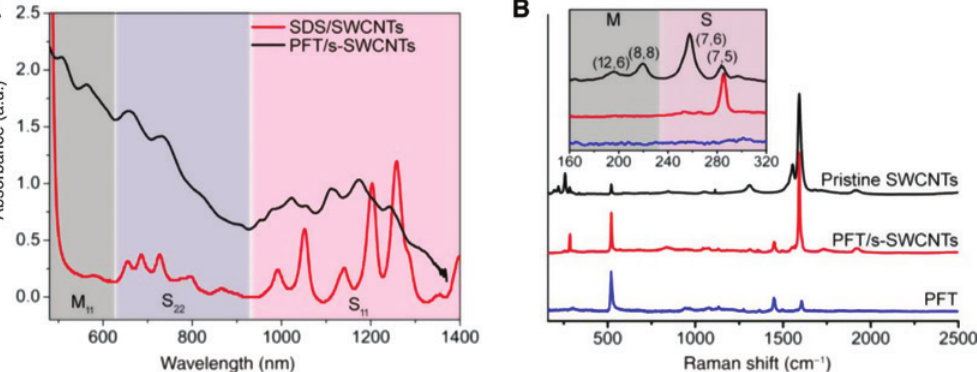
Figure 1: UV-vis-NIR absorption and Raman spectra. (A) UV-vis-NIR absorption spectrum for the PFT/s-SWCNTs (red) sample dispersed in toluene. Corresponding spectrum for the SDS-dispersed-pristine SWCNTs sample (SDS/SWCNTs) provided for reference. (B) Raman spectrum of PFT/s-SWCNTs (633 nm excitation). Spectra for the pristine SWCNTs and pure PFT are also provided for reference. The corresponding RBM regions are depicted in the insets. Note: for the insets, the box labeled “M” denotes the spectral region at which signals from m-SWCNTs are observed (160–220 cm −1 ), while the box labeled “S” denotes the region corresponding to s-SWCNTs (230–320 cm −1